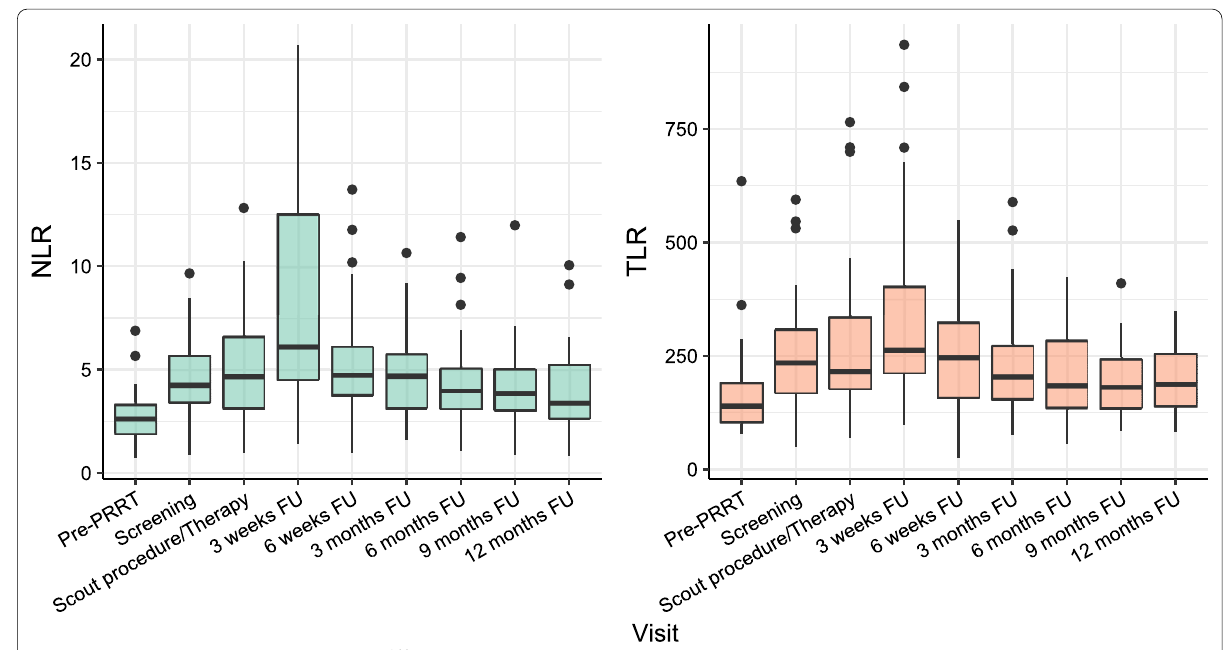
Fig. 2 Trends in absolute NLR and TLR after [ 166 Ho]-radioembolization, with a significant peak 3 weeks after treatment. FU